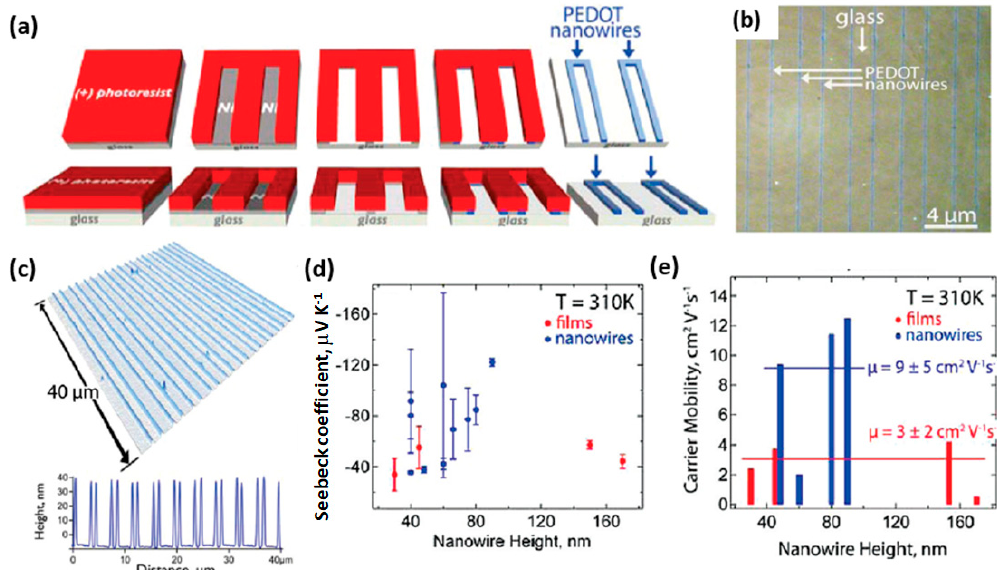
Figure 1. ( a ) Schematic synthesis of poly(3,4-ethylenedioxythiophene) (PEDOT) nanowire arrays using the lithographically patterned nanowire electrodeposition (LPNE) process. ( b ) Bright field optical micrograph of PEDOT nanowire pattered on glass. ( c ) Atomic force microscope (AFM) image of an array of 40 × 200 nm PEDOT nanowires on glass. A height versus distance trace across these nanowires is shown at bottom. ( d ) Measured Seebeck coefficient versus nanowire height for PEDOT nanowires and films at 310 K. ( e ) Electron mobilities versus the film or nanowire height, showing also (horizontal line) the mean mobility value. Readapted with permission from American Chemical Society [34].